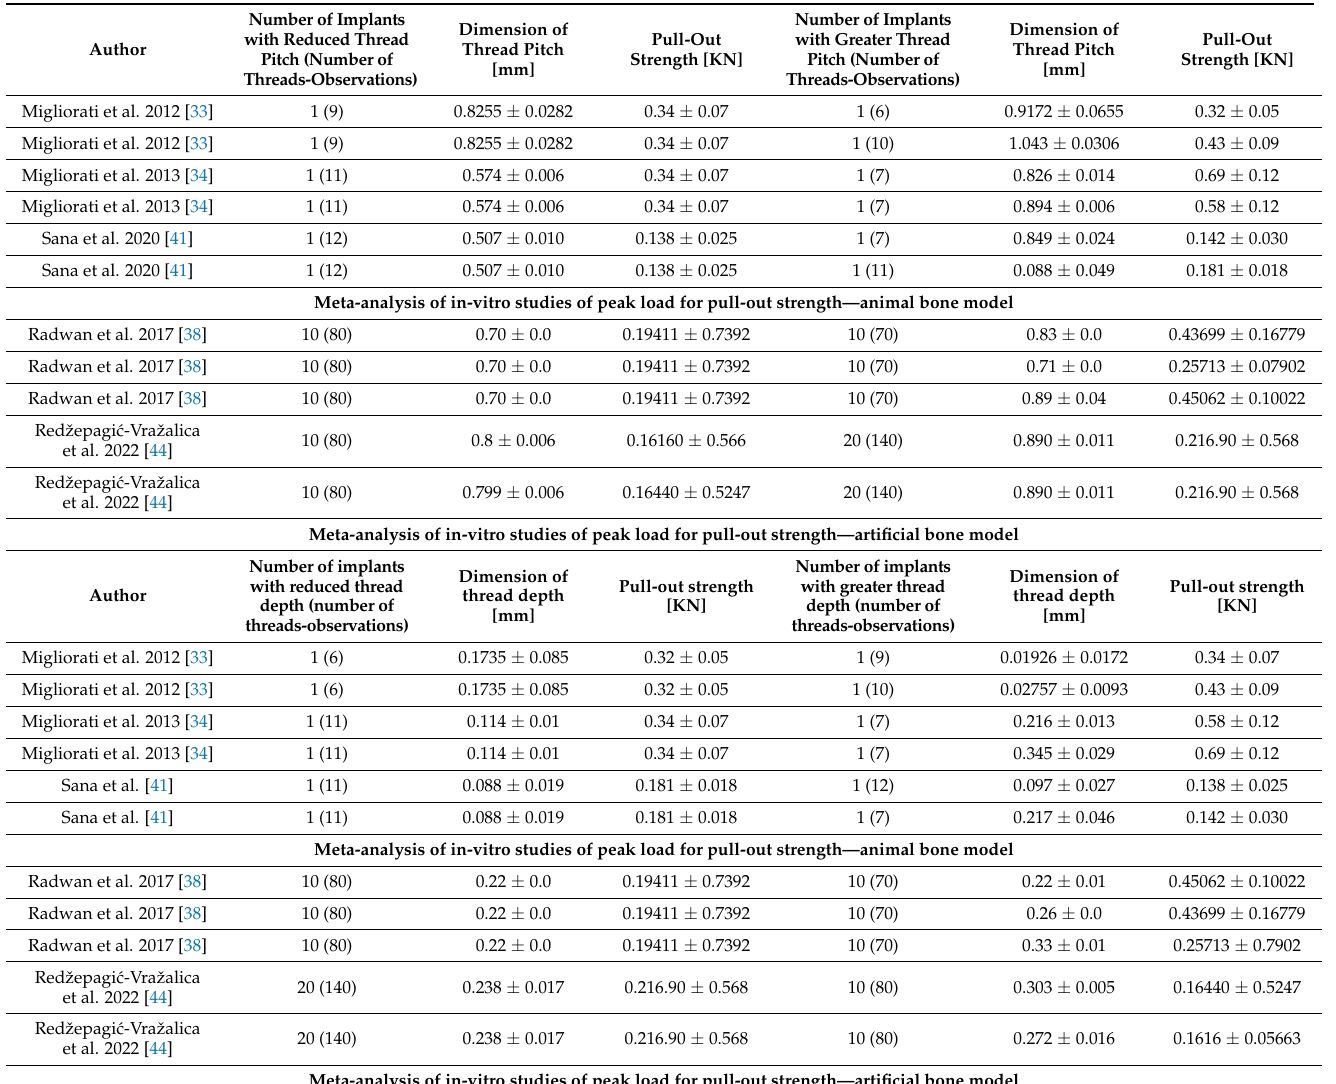
Table 5. Meta-analysis of in-vitro studies of peak load for pull-out strength—artificial bone